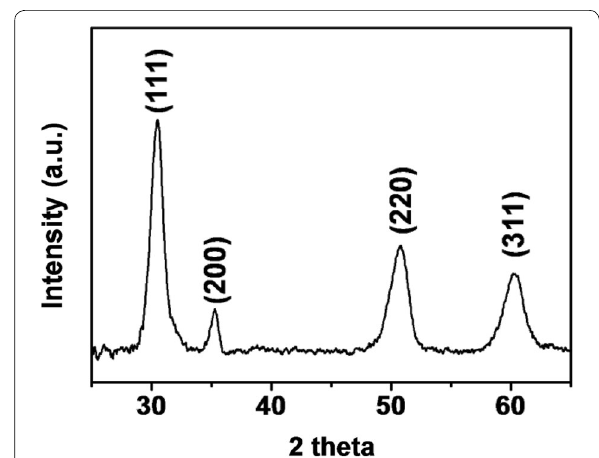
Fig. 3 XRD patterns of YSZ-NT arrays from beam line 5 A with the wavelength 0.7653 Å using Mar 345-image plate at Pohang Light Source (South Korea). For converting image to the 2D diffraction pat- tern, FIT2D program was used. The 2 θ of XRD pattern was recalcu- lated to the corresponding angles of λ 1.54 Å (Cu-Kα =